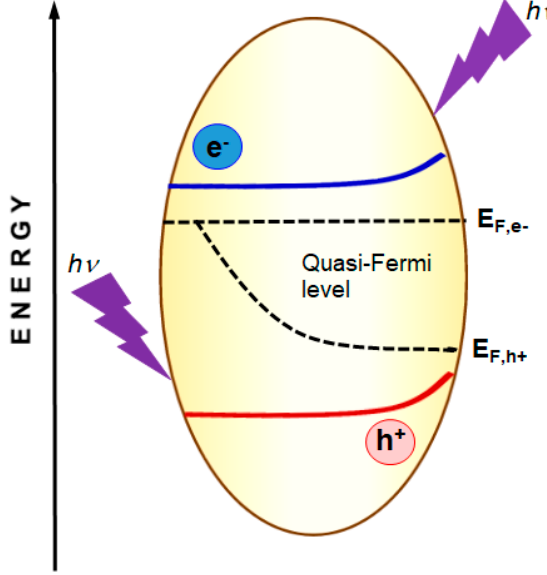
Figure 2. Energy of a CeO 2 semiconductor (n-type) and band positions in the semiconductor under equilibrium conditions after semiconductor–electrolyte contact and after irradiation.